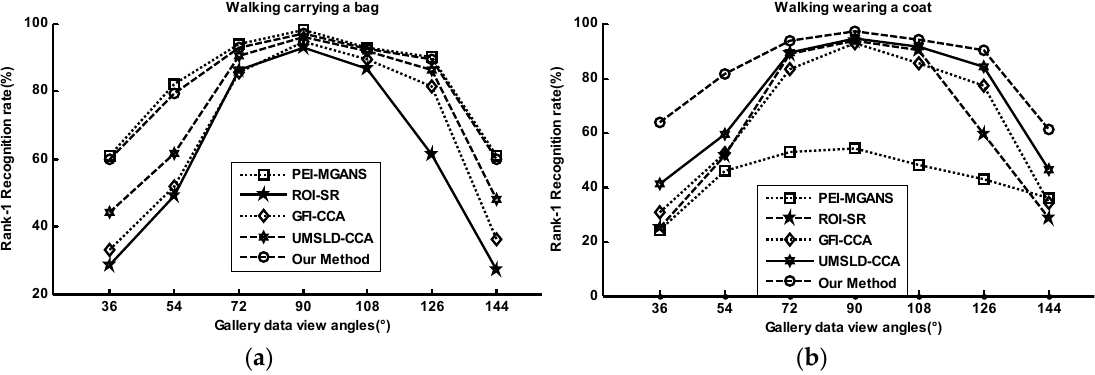
Figure 11. Rank-1 View-invariant gait recognition (%) under various conditions: probe data viewing angle of 90°.